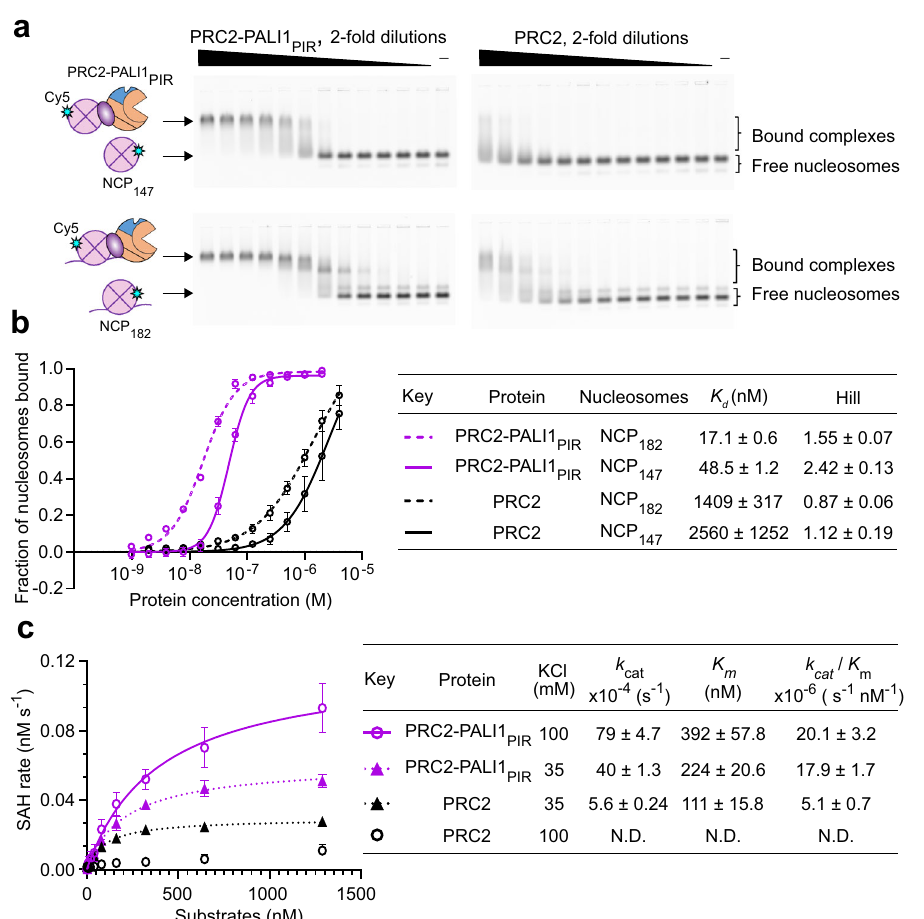
Fig. 7 PALI1 facilitates nucleosome binding by PRC2. a EMSA used to quantify the af fi nity of the indicated PRC2 complexes for H2A-Cy5-labelled nucleosome core particles substrate (top, NCP 147 ) and mononucleosomes with 35 bp linker DNA substrate (bottom, NCP 182 ). In all, 2-fold dilutions of the protein were carried out, starting from 2 µ M PRC2-PALI1 PIR and 4 µ M PRC2. b Quanti fi cation of the EMSA from a . Data represent the mean of three independent experiments and the error bars represent standard deviations. Standard errors of dissociation constants ( K d ) and Hill coef fi cients are indicated in the table. c Michaelis – Menten kinetic analysis of PRC2-PALI1 PIR (15 nM) and PRC2 complex (50 nM) on a nucleosomal array substrate. Colour key for the plot and KCl concentrations are indicated in the table. Data represents the mean of three independent experiments that were carried out on different days and error bars represent standard deviation. k cat , K M , and the catalytic ef fi ciency ( k cat / K M ) values are indicated with standard errors. Substrate concentrations were de fi ned by the octamer concentrations in the arrays. Progress curves con fi rmed that the reaction is at the linear range and evidence for the substrate quality are in Supplementary Fig. 7. Source data for this fi gure are provided as a Source Data fi